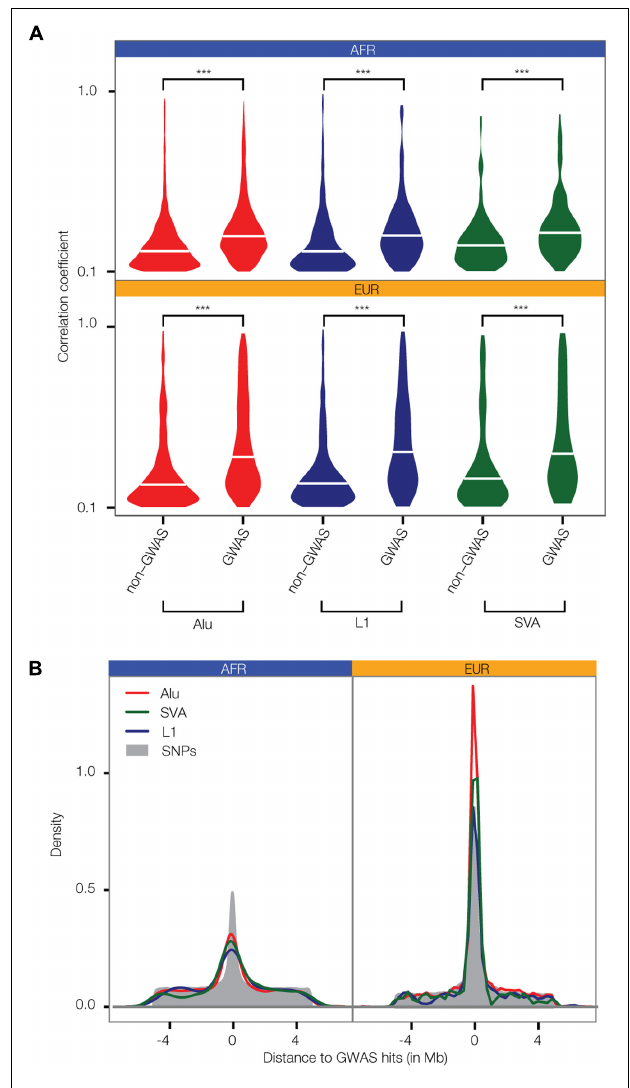
FIGURE 3 | Linkage between polyTE insertions and SNP disease-associations from GWAS. (A) Distributions of the allele correlation coefficients ( r ) are shown for (1) polyTE insertions and non-GWAS SNPs, and (2) polyTE insertions and GWAS SNPs. Higher correlation coefficients indicate tighter linkage. The significance of the differences for the non-GWAS SNP vs. the GWAS SNP correlation coefficient distributions are indicated (Kolmogorov–Smirnov test; ∗∗∗ P < 2.4 × 10 − 5 ). (B) Density distributions of the distance between polyTE insertions and SNPs to the nearest GWAS disease-associated SNP. Correlation coefficient (A) and density (B) distributions are shown separately for the Alu (red), L1 (blue), and SVA (green) TE families in the African (AFR – blue) and European (EUR – orange) population groups.